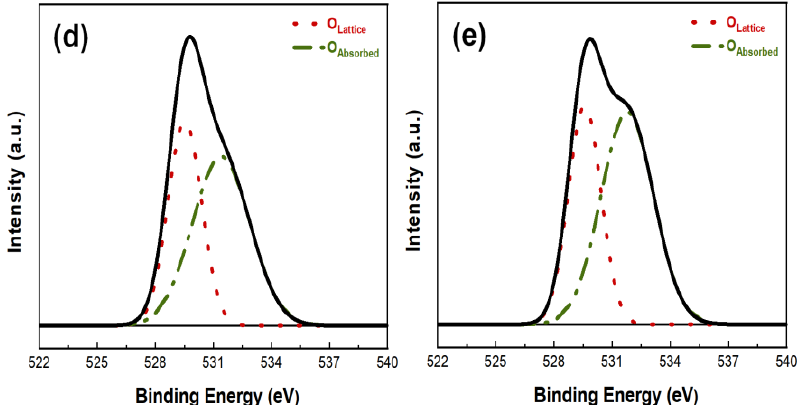
Figure 5. X-ray photoelectron spectrum of O 1s ( a ) CFO ( b ) CO-CFO-12.5 ( c ) CO-CFO-25 ( d ) CO- CFO-37.5, and ( e ) CO.